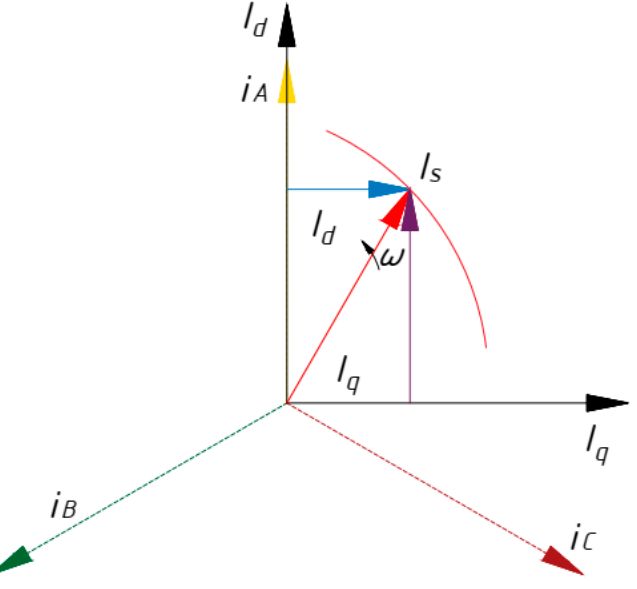
Figure 1. Vector diagram of Park’s transformation (Gorev).